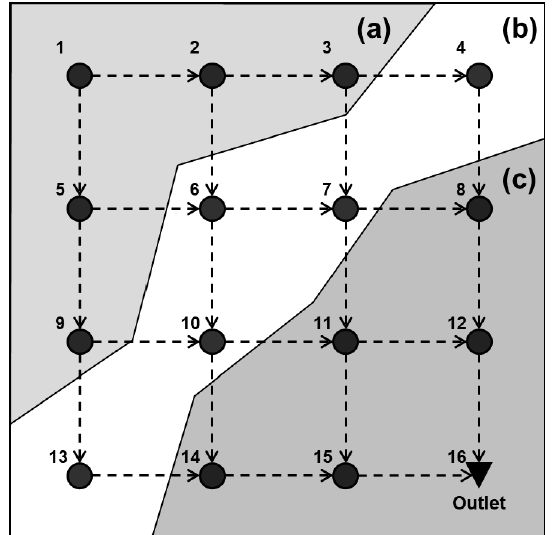
Figure 5. S-city urban drainage network. (a) northwestern corner; (b) midtown; and (c) southeastern corner sectors.